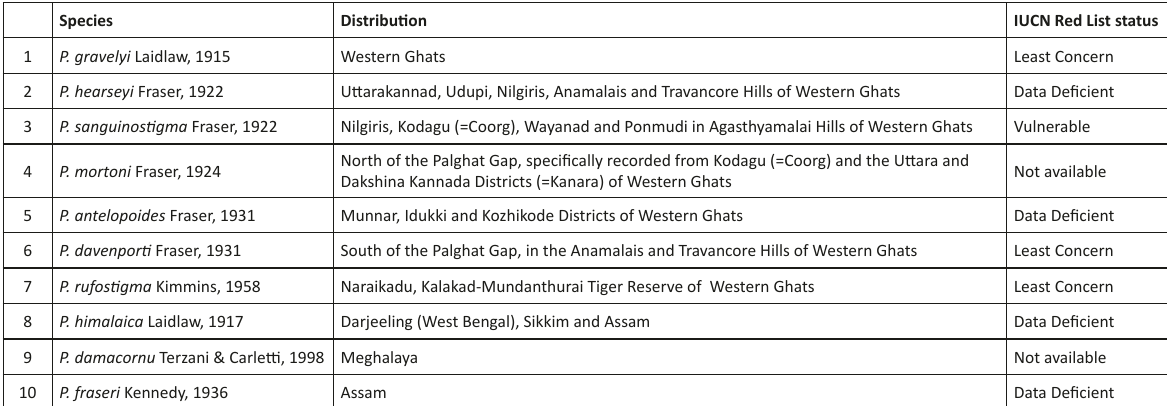
Table 1. Overview of genus Protosticta Selys, 1885 in